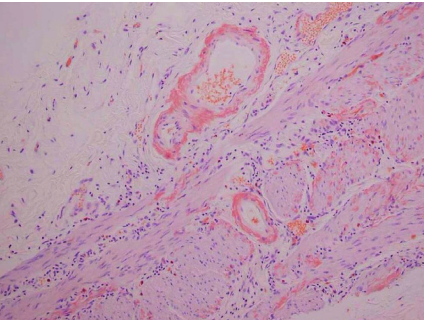
Figure 3: Postoperative histology of gallbladder with Congo Red stain. Amyloid deposition is seen in the gallbladder